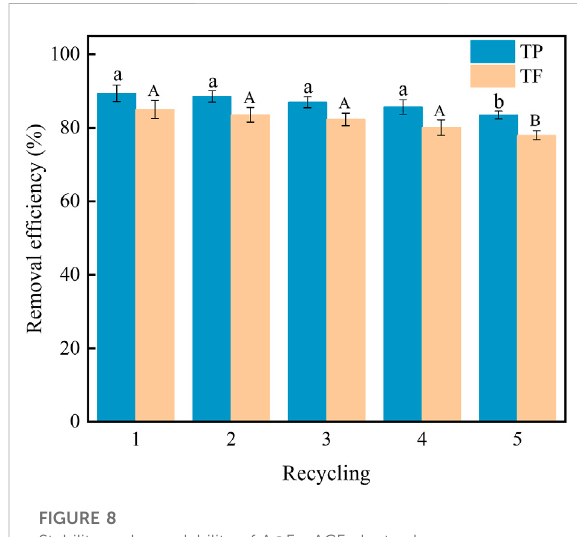
Stability and recyclability of A@Fe-ACF